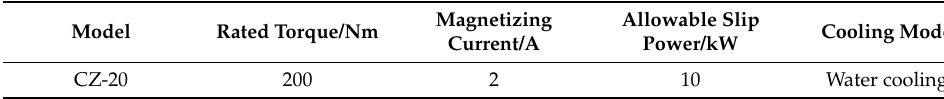
Table 3. Related parameters of magnetic powder brake.